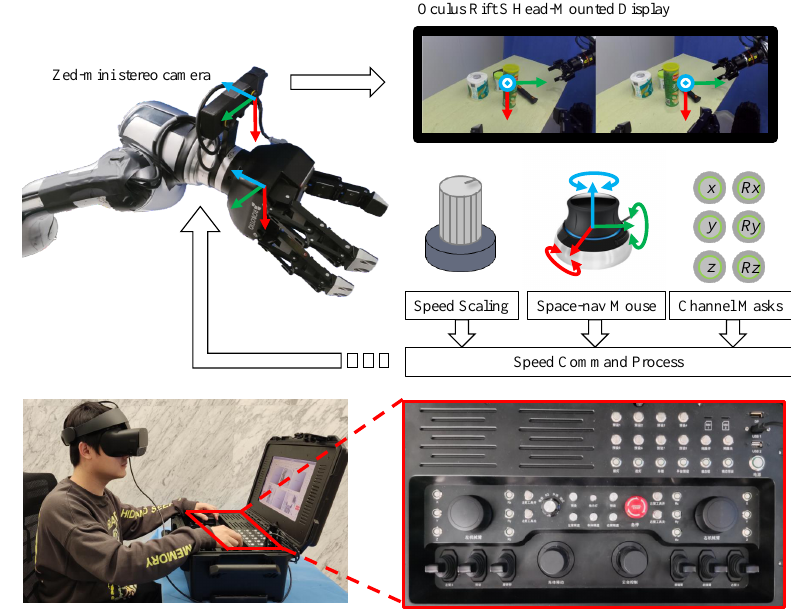
Figure 6. Schematic diagram of the immersive teleoperation